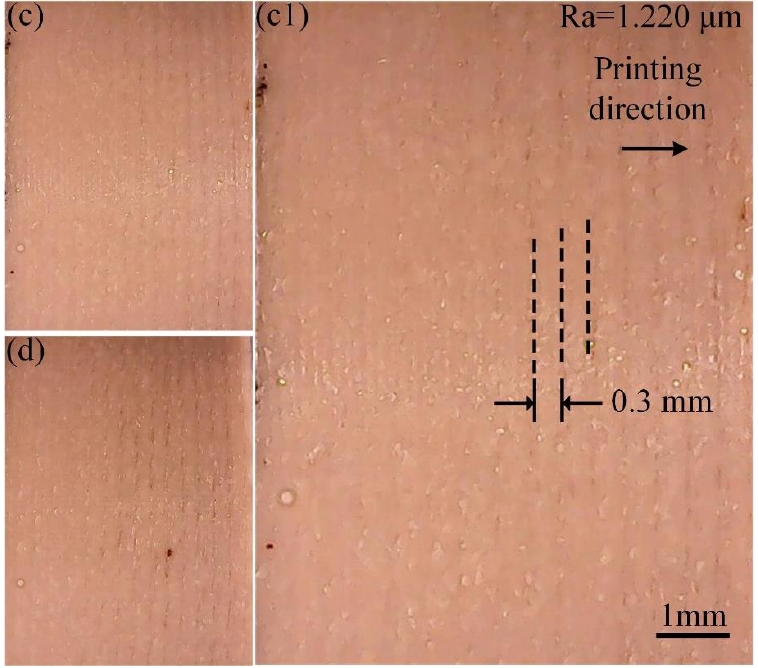
Figure 5. Surface morphology of milled specimens: ( c ) 90° printing, milling at the X direction; ( d ) 90° printing, milling at the Y direction; ( c1 ) enlarged image of subfigure ( c ).